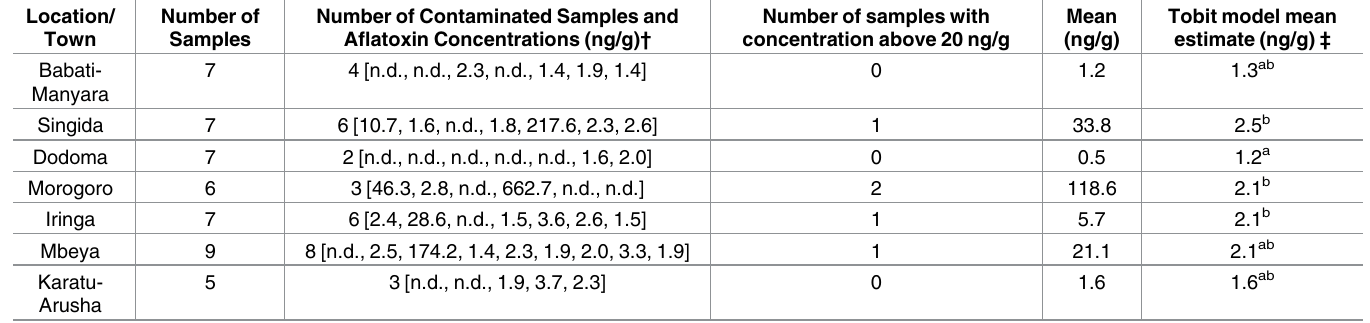
Table 4. Aflatoxin concentrations in sunflower seeds collected from micro- and small-scale sunflower oil processors in Tanzania in the sun- flower-harvesting season of 2015. Location/ Town